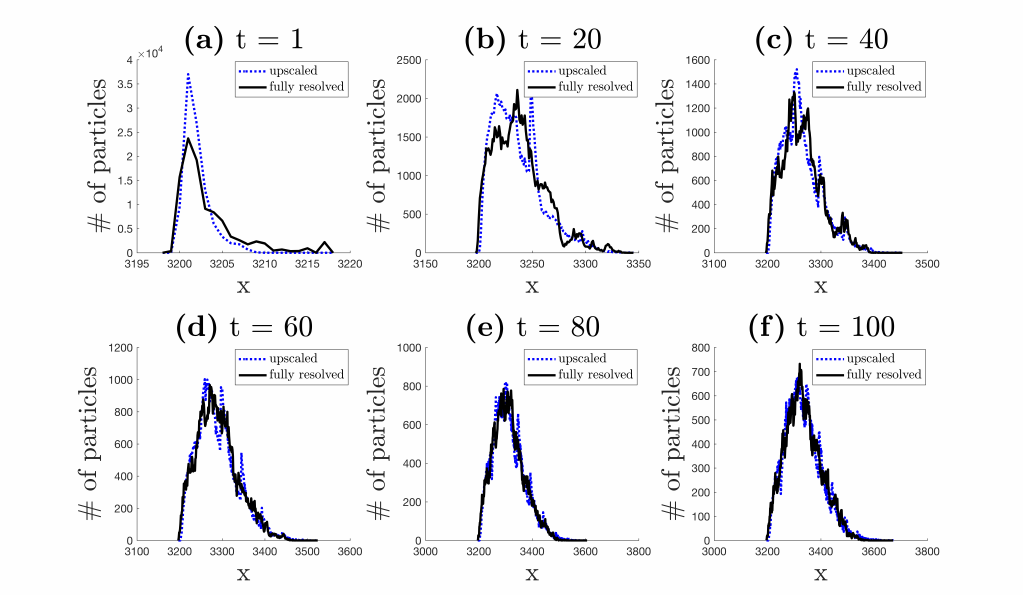
Figure 7. Histogram of particle x locations at times ( a ) t = 1, ( b ) t = 20, ( c ) t = 40, ( d ) t = 60, ( e ) t = 80, and ( f ) t = 100 for both the fully resolved particle tracking simulations (solid black line) and the Spatial Markov model with the downscaling method described in Section 4.1 (dashed blue line). The bin size selected for the histogram is the same as the fully resolved grid